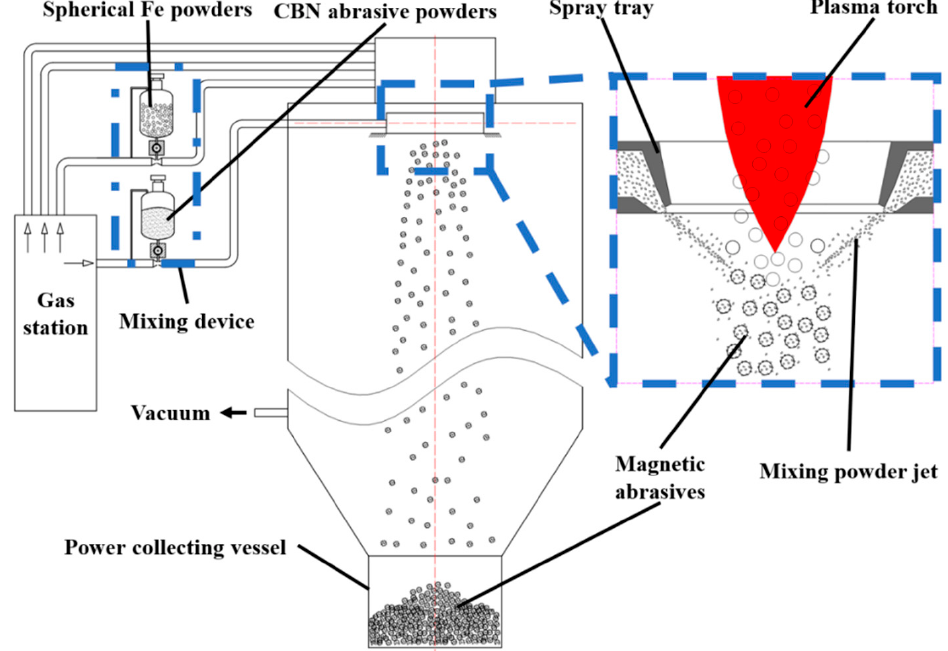
Figure 1. Principle diagram of magnetic abrasive preparation by plasma molten metal powder bonding with hard abrasives.